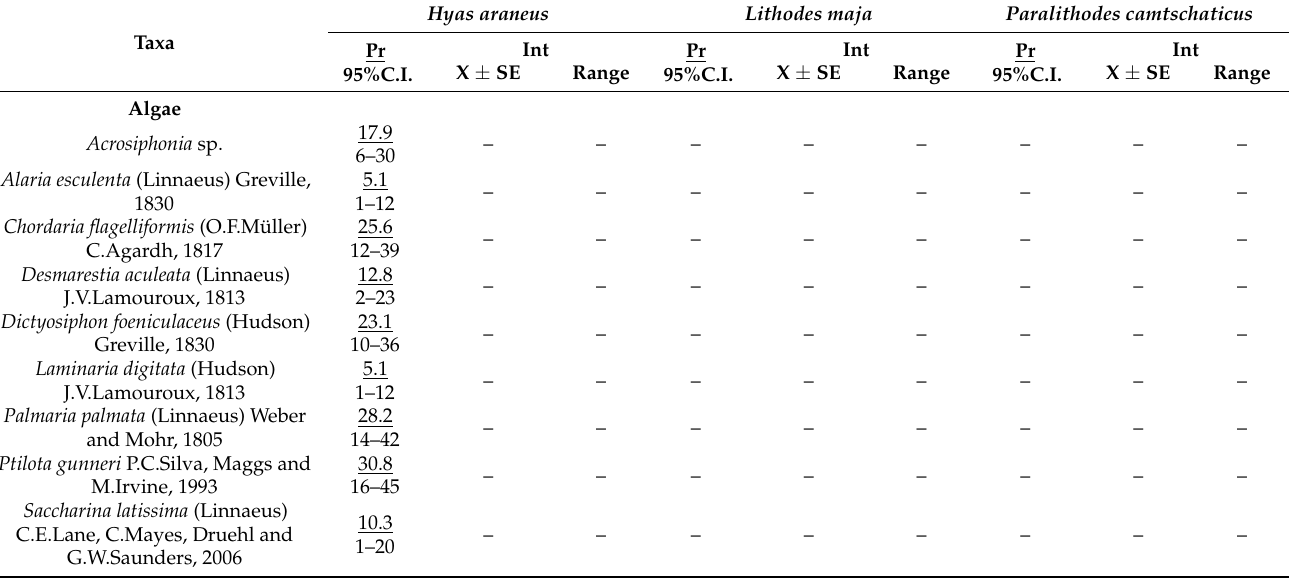
Table 1. List of taxa and infestation indices for associated organisms found on great spider crabs ( Hyas araneus ), northern stone crabs ( Lithodes maja ), and red king crabs ( Paralithodes camtschaticus ) in the coastal Barents